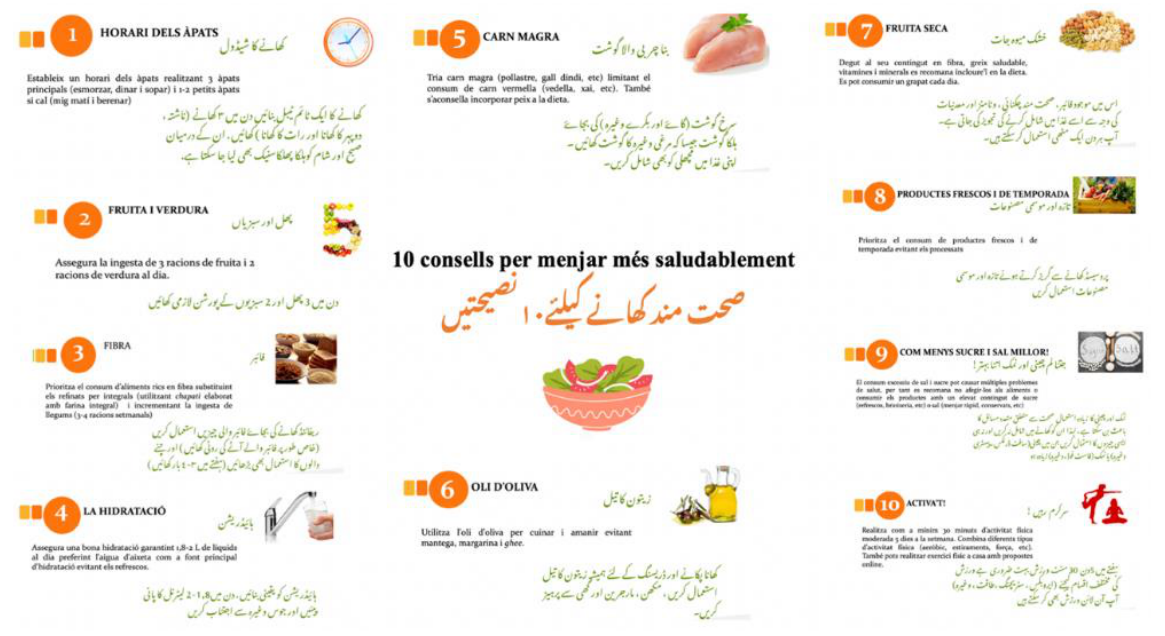
Figure 8. Infographic of 10 tips for healthy eating.